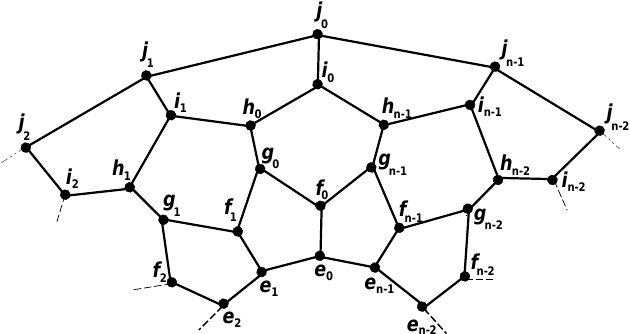
Figure 5. The graph of convex polytope R n .